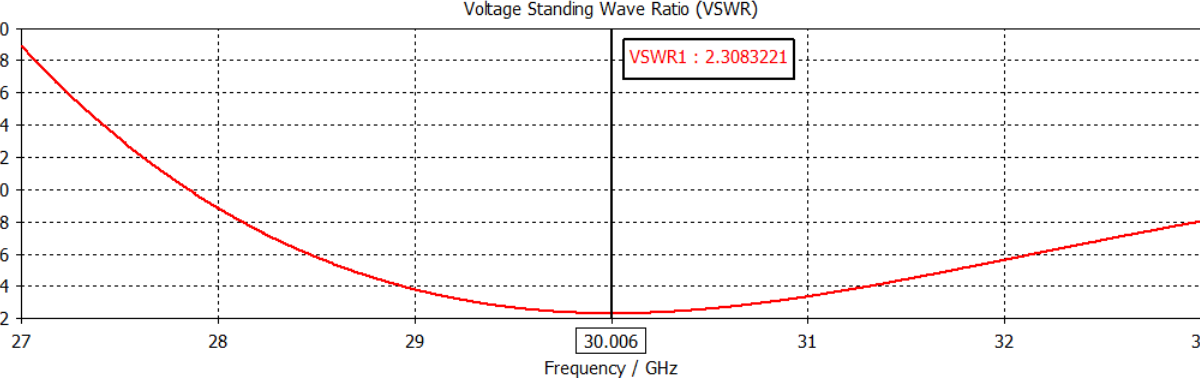
Figure 12. VSWR Performance vs. Frequency